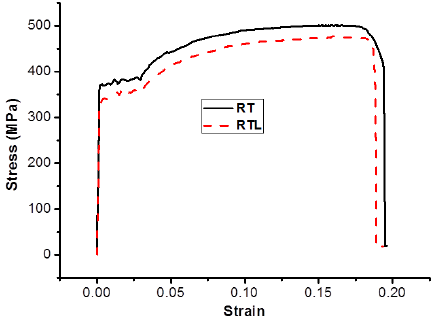
Figure 16. Stress ‐ strain curves of RT and RTL specimens. Figure 16. Stress-strain curves of RT and RTL